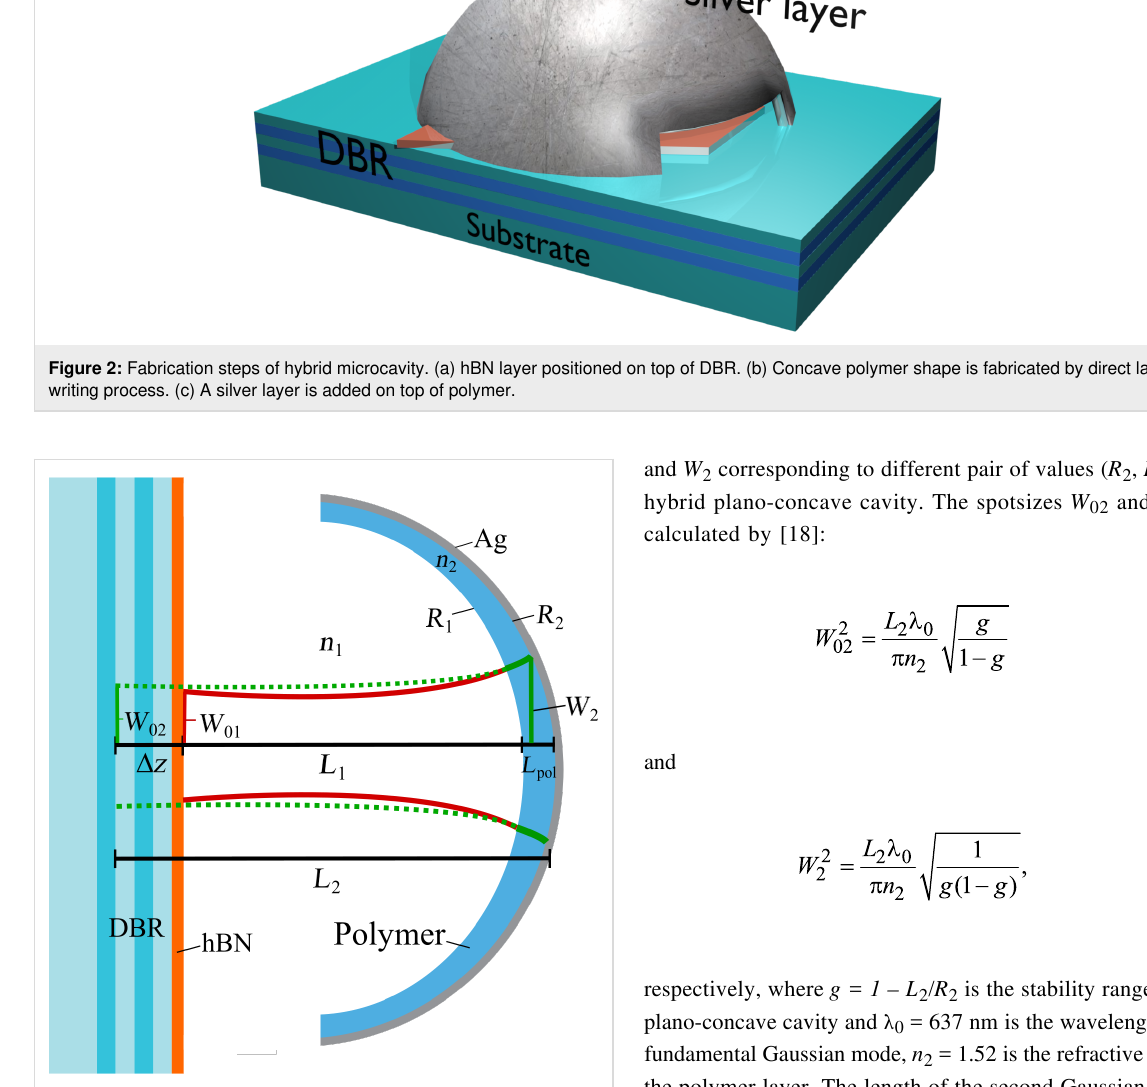
By setting an arbitrary range of values for the length of the second Gaussian beam L 2 and radius of curvature R 2 of our plano-concave microcavity, Figure 4 shows the spotsizes W 02